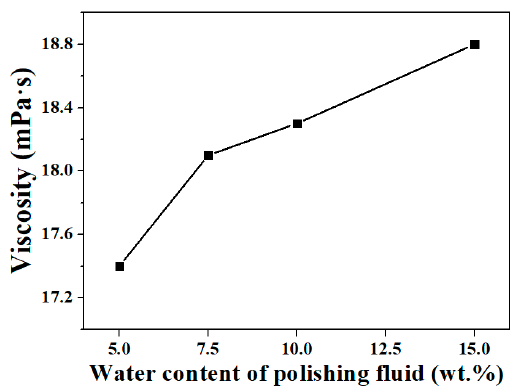
Figure 4. Variations in the viscosity of polishing fluid with water content.